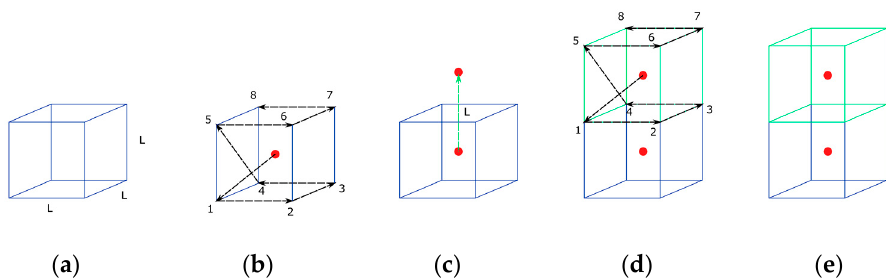
Figure 5. Connectivity and element generation for the 3D: ( a ) initial voxel element; ( b ) path vectors; ( c ) position of the new centroid; ( d ) new nodes and connectivity definition; ( e ) element attributes.